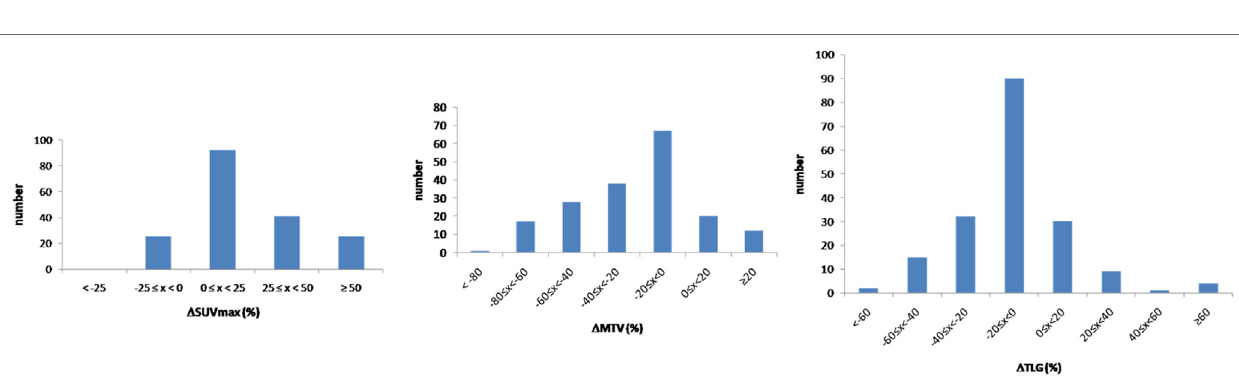
FigUre 3 | Δ SUVmax, Δ MTV, and Δ TLG ranked by increasing difference value in the population.